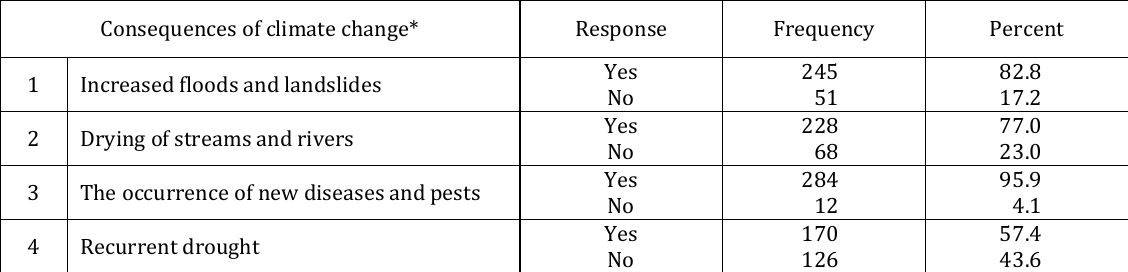
Table 5. Consequences of climate change (Source: Survey, April 2018)